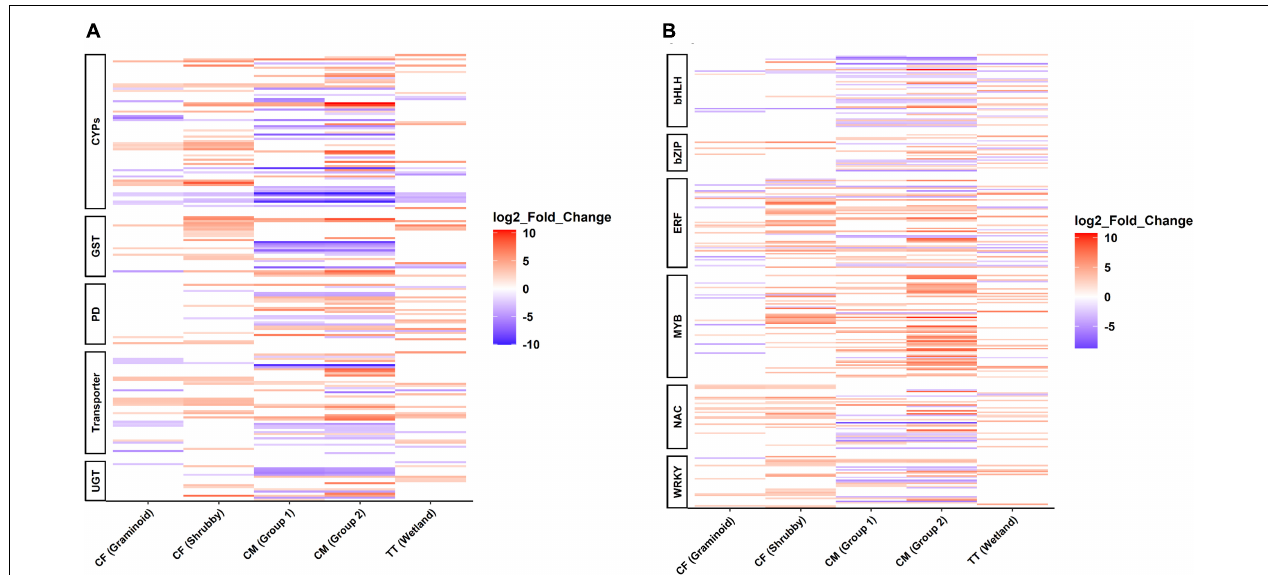
FIGURE 6 | Differentially expressed genes (DEGs) in willow in response to oil sands tailings induced stress. DEGs involved in xenobiotic detoxification pathways (A) and in stress-responsive transcription factors (B) (known from other studies, Yoon et al., 2020). Red indicates upregulated genes and blue indicates downregulated genes (only significantly deregulated genes LFC > 2, padj < 0.05 are shown in the figure). Cytochrome P450 (CYPs), glutathione S-transferase regulatory process (GST), protein detoxification (PD), ABC transporters (Transporters), UDP-glycosyltransferase (UGT), Basic helix-loop-helix (bHLH), Basic leucine zipper (bZIP), Ethylene-responsive factor (ERF), NAC [derived from no apical meristem (NAM), Arabidopsis transcription activator factor 1/2 (ATAF1/2), and cup-shaped cotyledon 2 (CUC2)], MYB [MYB (myeloblastosis) family of transcription factors]. CF, centrifuge tailings; CM, co-mix tailings; TT, Thickened